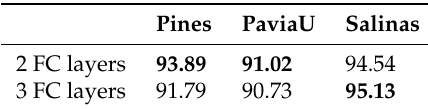
Table 4. Classification performance of the SPPF framework using CNN 2 -lite as subnetworks with different numbers of FC layers (OA shown in